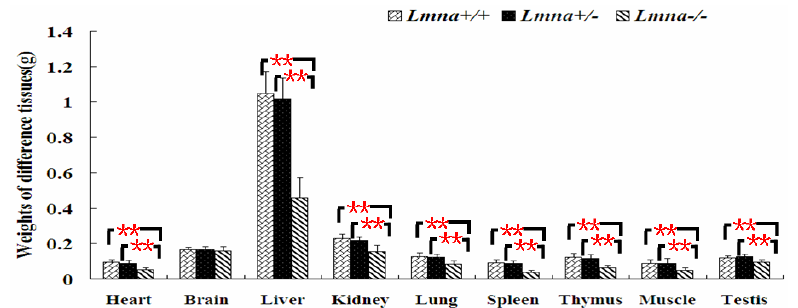
Figure 3. Tissue weights of Lmna +/+ , Lmna +/- and Lmna -/- mice. Most tissue weights of Lmna -deleted mice at 4 weeks after birth were decreased. The data are presented as the mean  SD, n = 30. ** Indicates p<0.01.